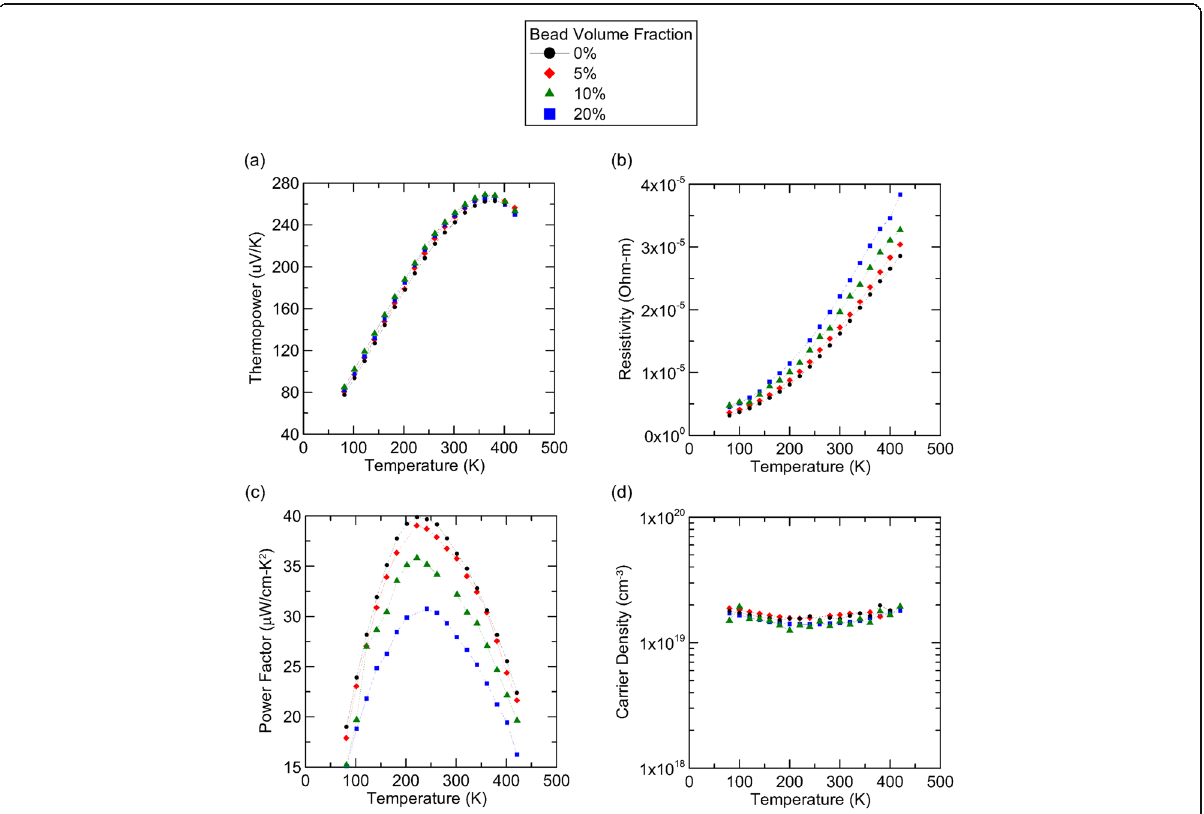
Fig. 2 Transport properties of a composite made of Pb-coated glass beads in a (Bi 0.25 Sb 0.75 ) 2 Te 3 host matrix. The thermopower, resistivity, power factor ( α 2 σ ), and Hall carrier concentration are shown as functions of temperature for the various volumetric filling fractions